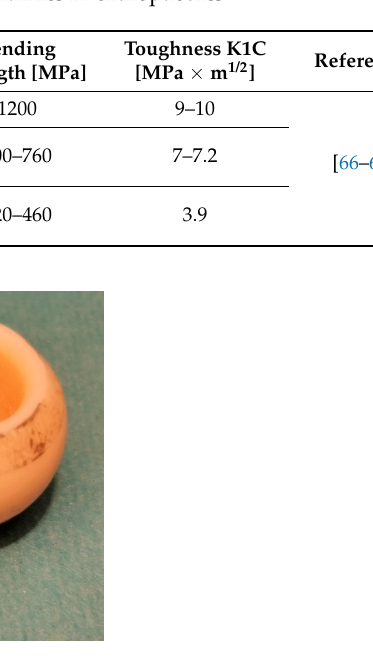
Table 2. Physical characteristics of the most popular ceramics in orthopaedics.